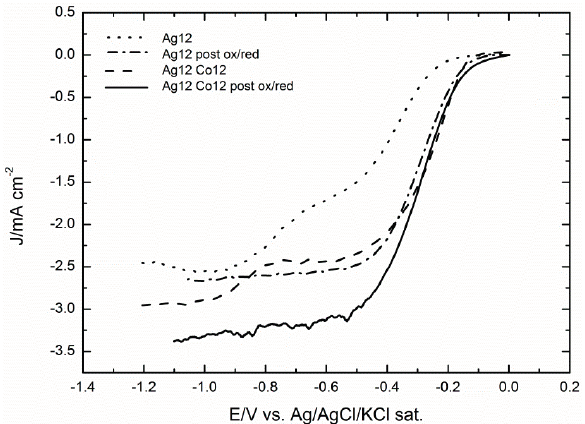
Figure 10. ORR of the best performing catalyst made by GC/Ag12Co12 before and after the oxidative/reductive treatment recorded at 500 rpm and with a scan rate of 50 mV·s − 1 . The curves are compared to the GC/Ag samples of [31].